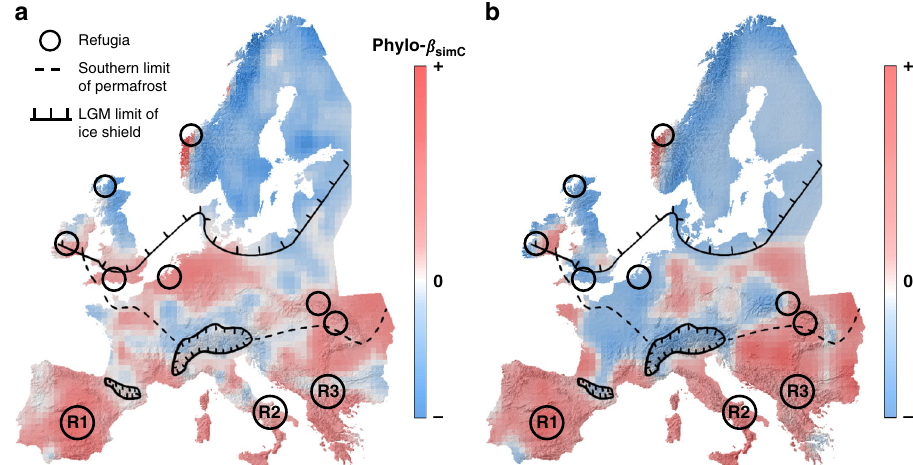
Fig. 1 Phylo- β simC across Europe. a, b Phylo- β simC is de fi ned as the residuals of each raster cell to its 24 nearest neighbors from a generalized linear model with true phylogenetic turnover (phylo- β sim , corrected for species richness effects) as dependent variable and environmental and geographic distance among sampled sites as explanatory variables for angiosperms ( a ) and gymnosperms ( b ). Circles indicate refugia with the three main potential refugia in the South (R1: Portugal – Spain, R2: Italy, and R3: Balkans) and potential Northern refugia redrawn from refs. 27,52 indicated by smaller, unlabeled circles. The southern limit of the permafrost and the maximum extension of ice sheets in Europe during the last glacial maximum are illustrated by the hashed line and the scaled line, respectively, with the ice on the scaled side of the line (redrawn from Taberlet and colleagues 27 ). The underlying hillshade maps of Europe are based on the digital elevation model of the European Environment Agency 81